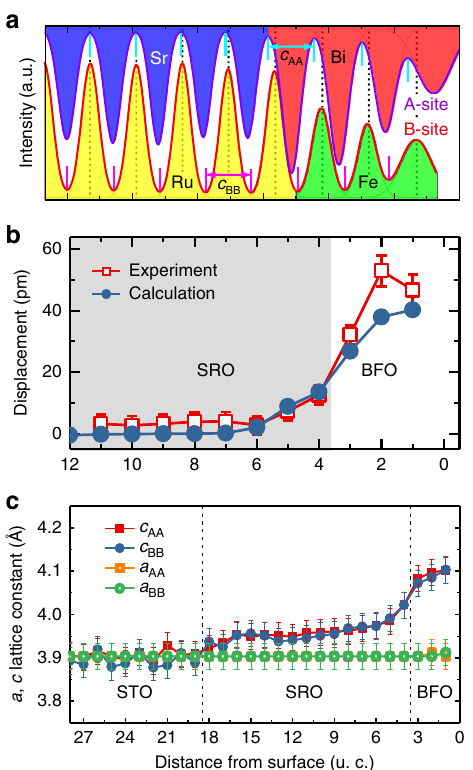
Fig. 2 Quantitative analysis of the off-center displacement and lattice parameters in BFO by experimental and calculated data. a The STEM intensity pro fi les of A-site (top, purple) and B-site (down, red) cations across heterointerface of SRO/BFO along the purple and red line in Fig. 1d. The short cyan lines represent the center of A-site atoms, while the black dashed lines represent the position of B-site atoms. b The averaged off- center displacement of B-site cations nearby the SRO/BFO interface in experiment and calculation. The mean value was calculated by averaging the position value over 28-u.c. parallel to the interface from STEM images at several different areas. The simulation cell in the calculations is SRO/ BFO/vacuum. The SRO region is shaded. c The c and a axis lattice parameters deduced from the distance of A – A (Bi – Bi, Sr – Sr) and the distance of B – B (Fe – Fe, Ru – Ru). The error bars mark the standard deviation with respect to averaging along each lattice